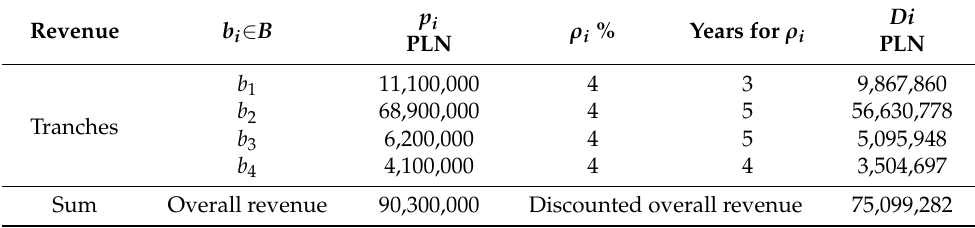
Table 2. Primary initial data of